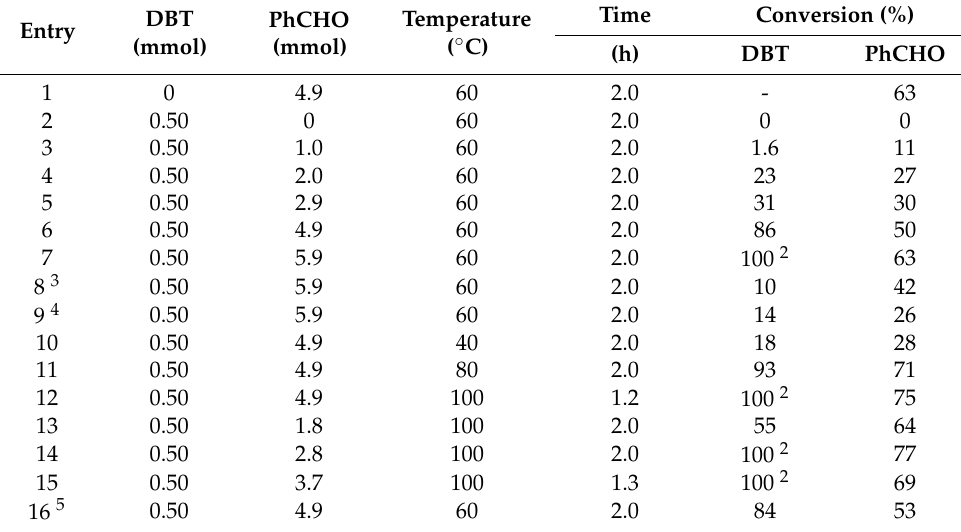
Table 2. Aerobic co-oxidation of DBT and PhCHO catalyzed by HPA-1 1 .